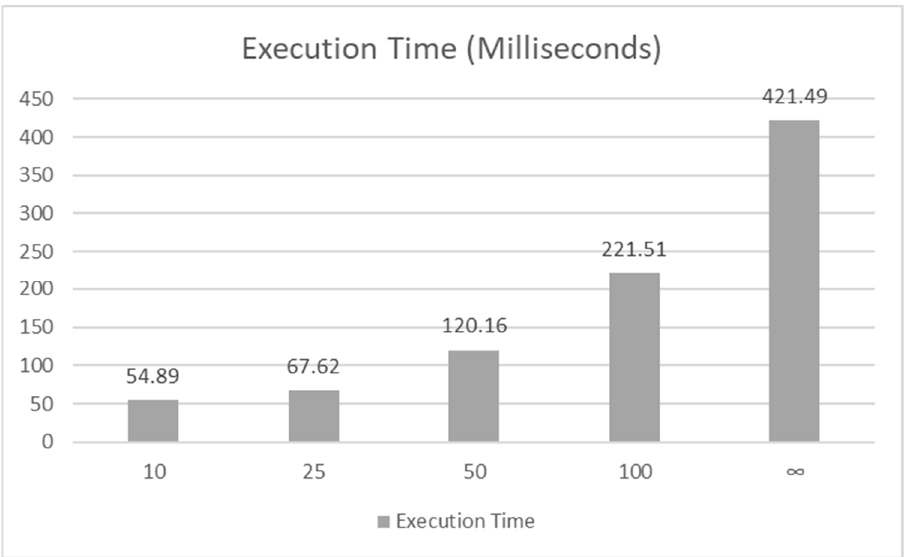
Figure 10. Execution time of the TSPDA by Slice Count.